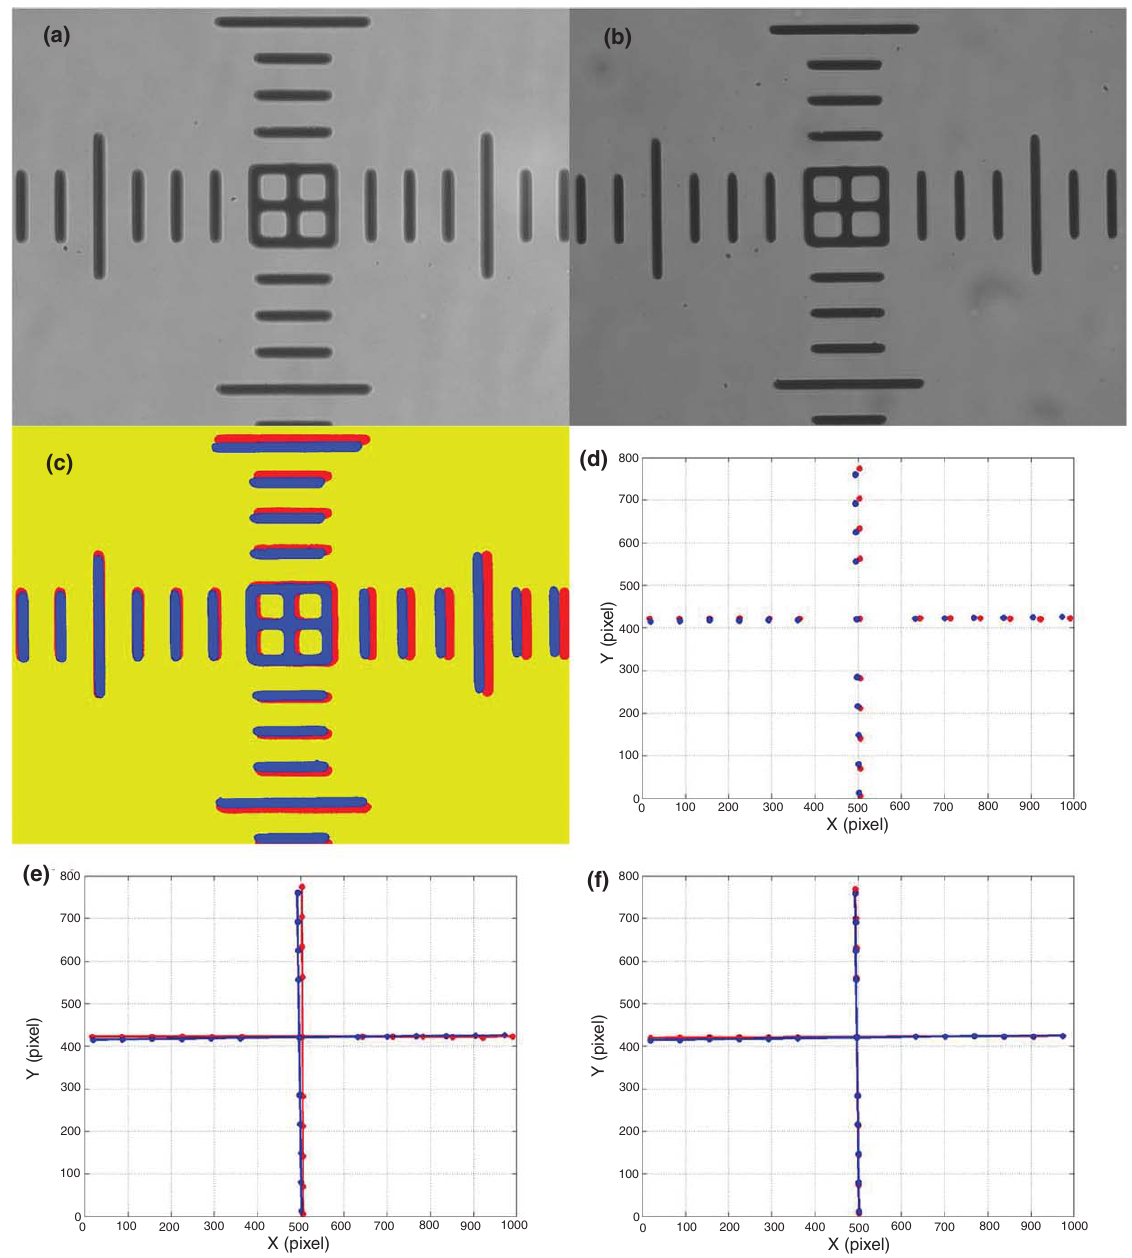
Fig. 7. Detector alignment measurement. The shown images were acquired under the 60 × objective. (a) Image 1 taken by camera 1. (b) Image 2 taken by camera 2. (c) Superimposed image 1 (red) and image 2 (blue). (d) The centroids of the marks. (e) The centroids with the perpendicular lines they fit into. (f) The centroids and the lines after the alignment by the proposed method.